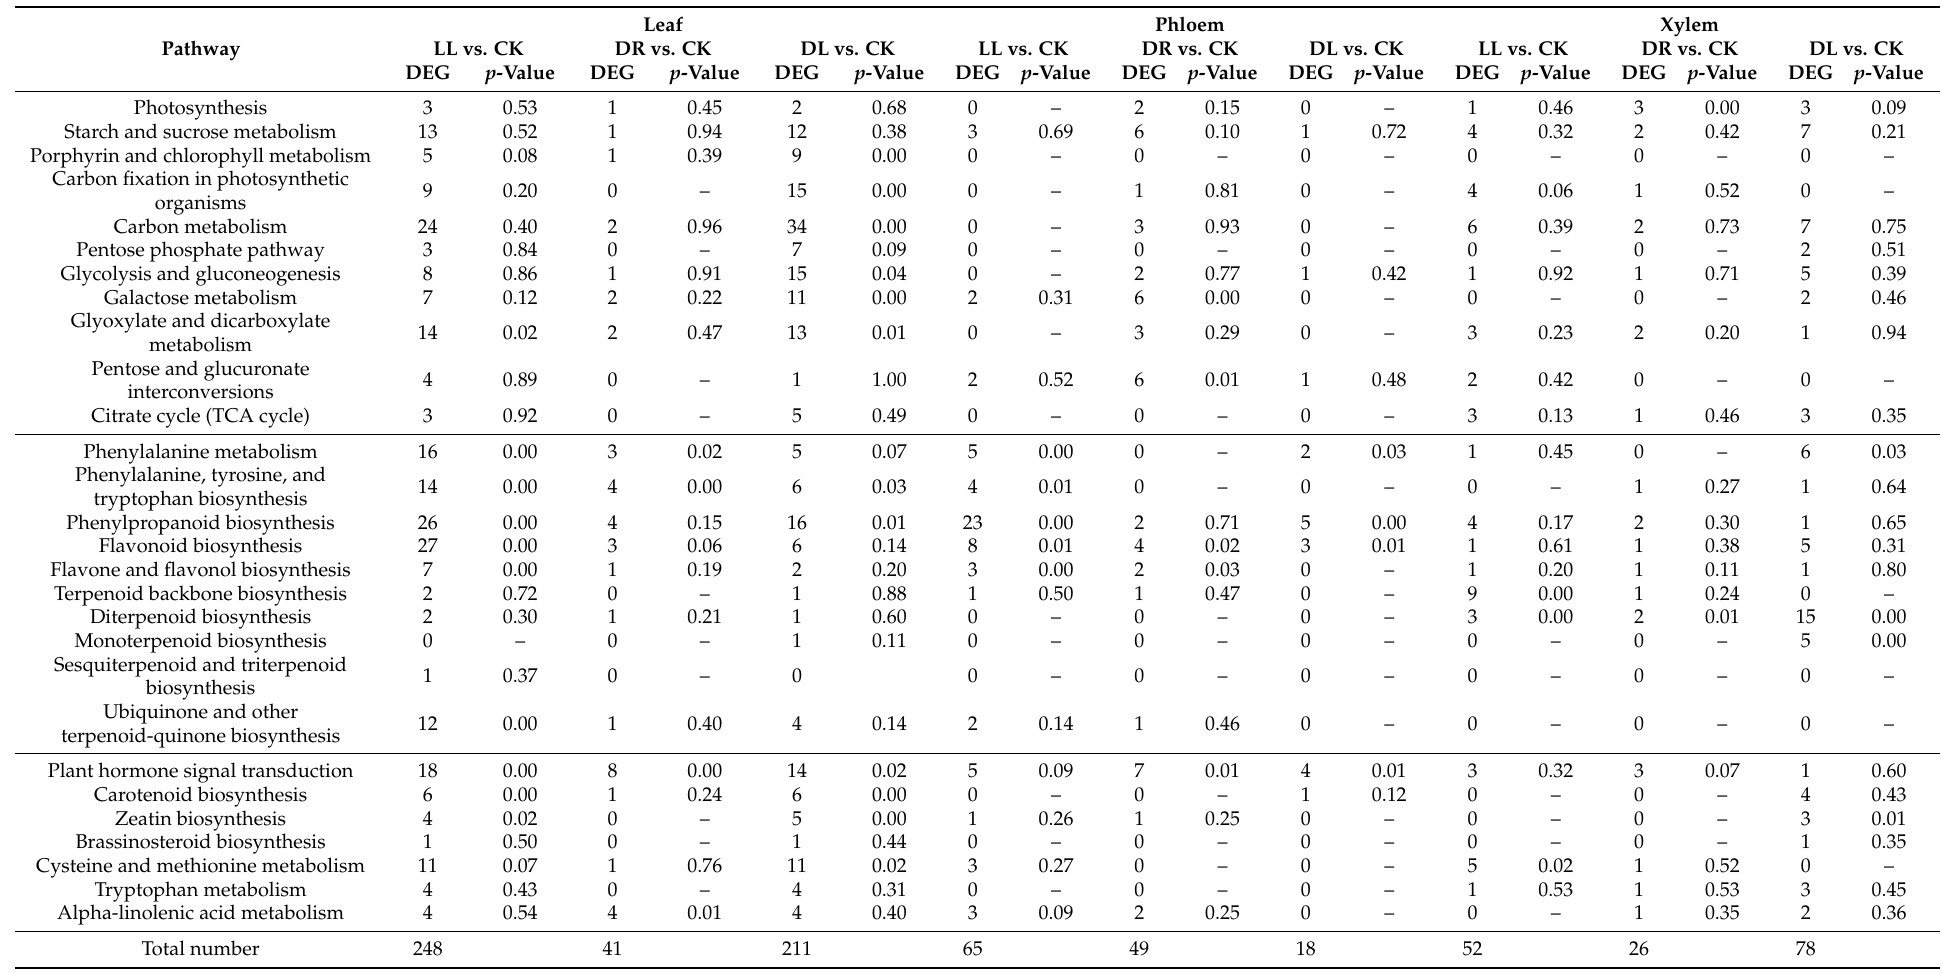
Table 3. Numbers of DEGs involved in main KEGG pathways of carbon metabolism, secondary metabolism, and plant hormones in leaves, phloem, and xylem. CK: control; LL: low light; DR: drought; and DL (DR + LL): the combined stress of drought and low light. Every treatment included three individual repeats, each consisting of one top, current-year branch (approximate 10 cm) for leaves, phloem, and